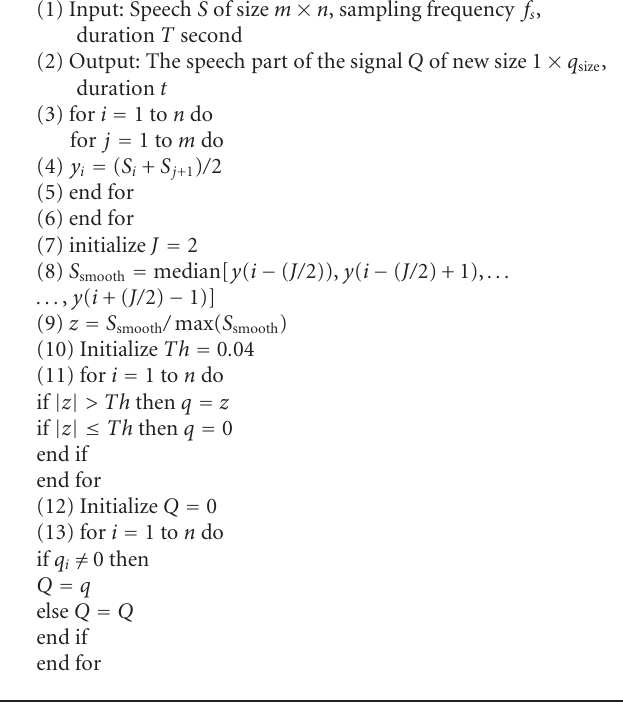
Algorithm 4: Preprocessing algorithm.